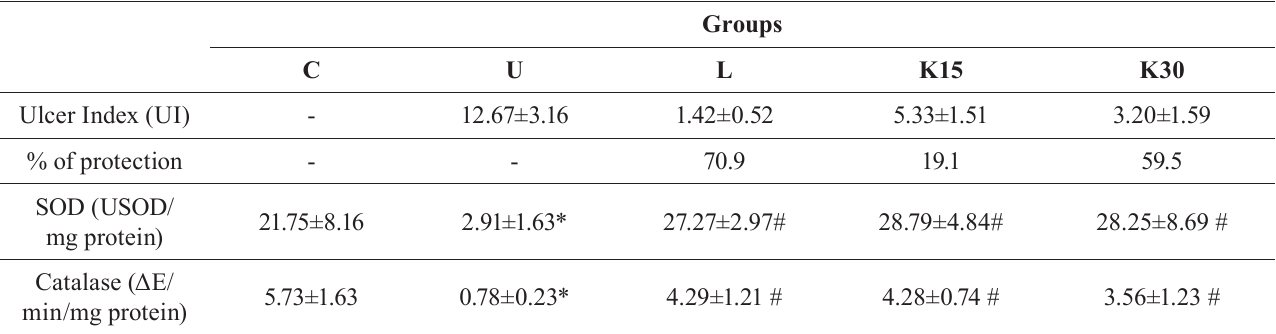
TABLE I - M acroscopic evaluation of ulcer lesion and antioxidant enzyme